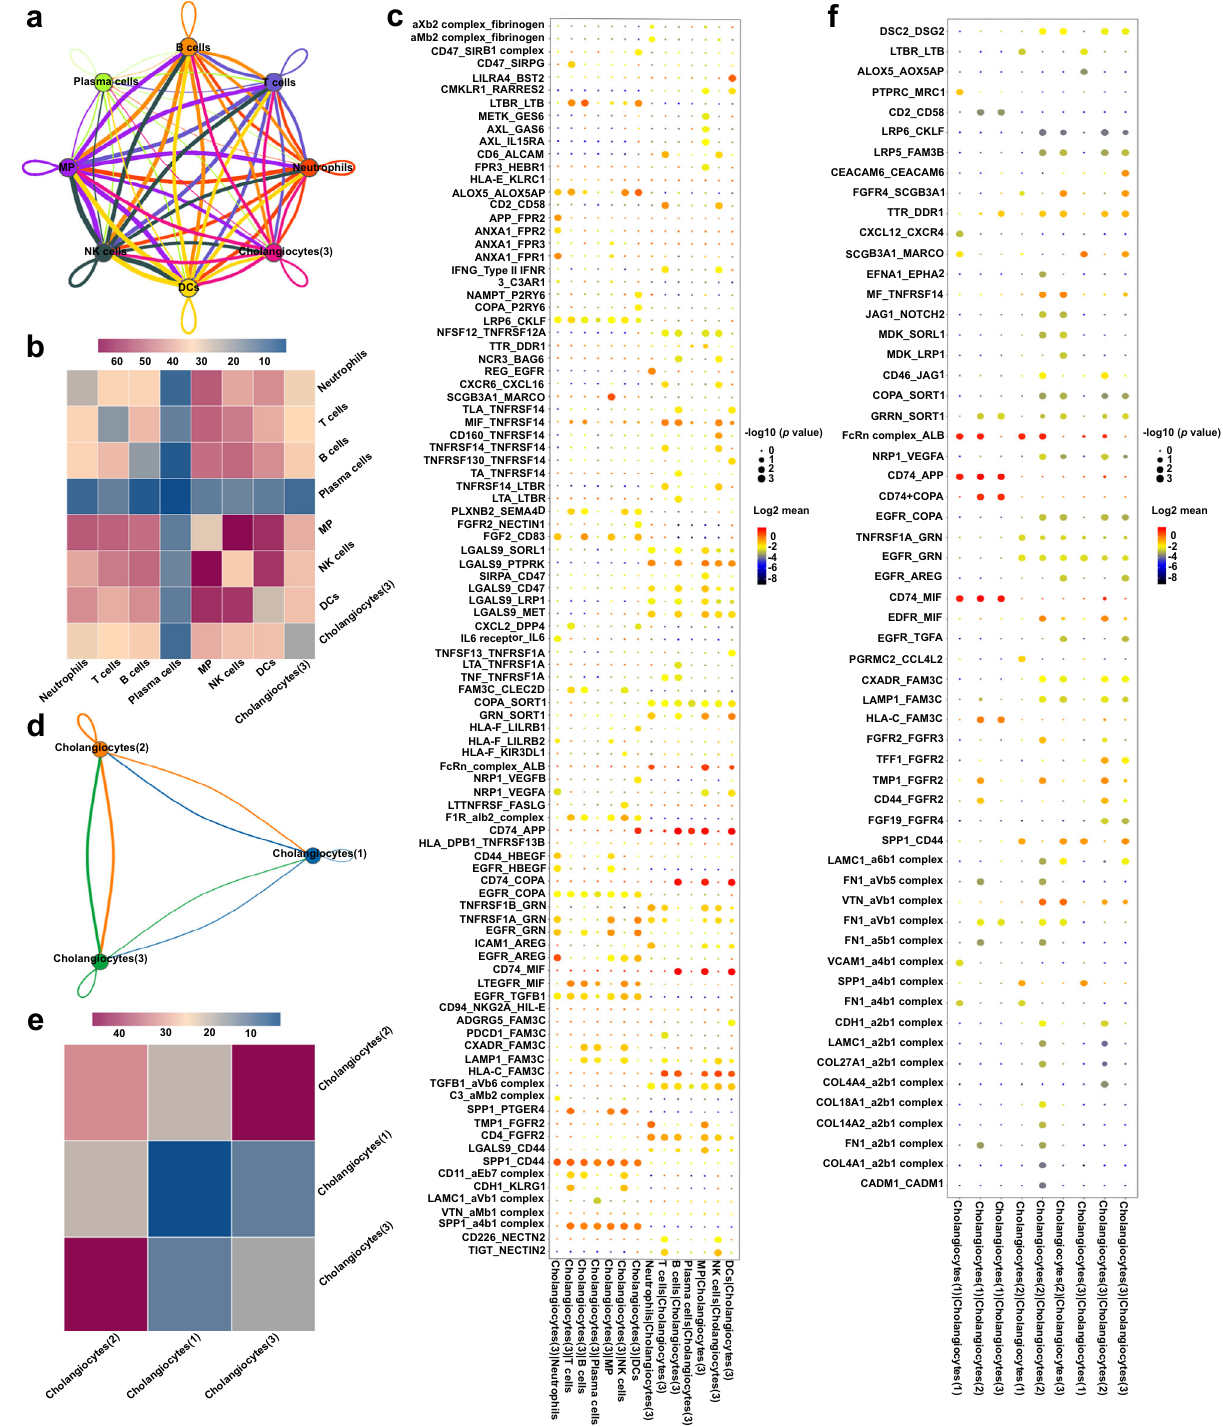
RNA extraction, and quantitative RT-PCR Total RNA was extracted from the isolated cholangiocytes using Trizol reagent (Takara Bio, Cat#9109) and reversely transcribed into cDNA for RT-qPCR analysis using the primers provided in Supplementary Table 15. Glyceraldehyde-3-phosphate dehydrogenase ( GAPDH ) was used as an internal control. The data were analyzed by 2 − ΔΔ Ct